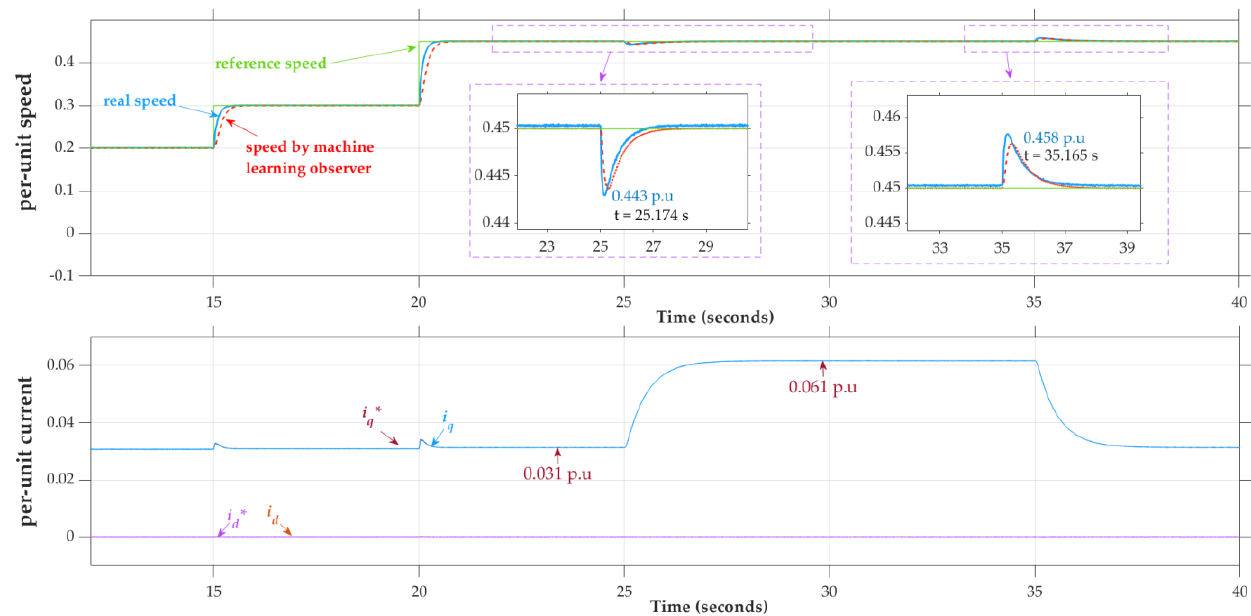
Figure 13. Simulation results for current responses in the d-q axis.